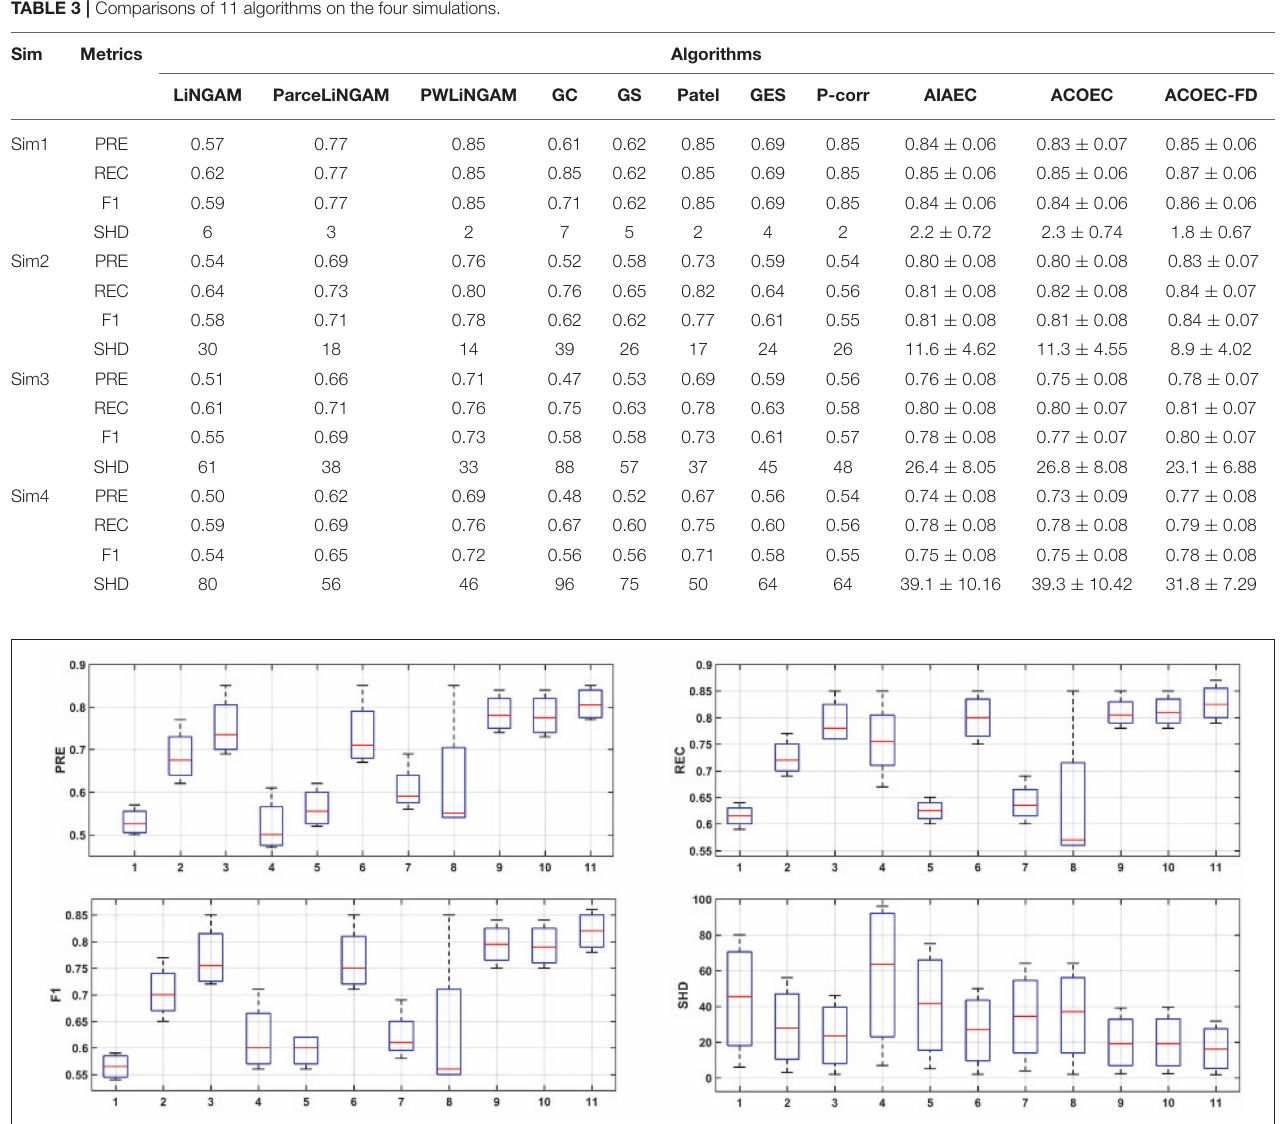
TABLE 3 | Comparisons of 11 algorithms on the four simulations.